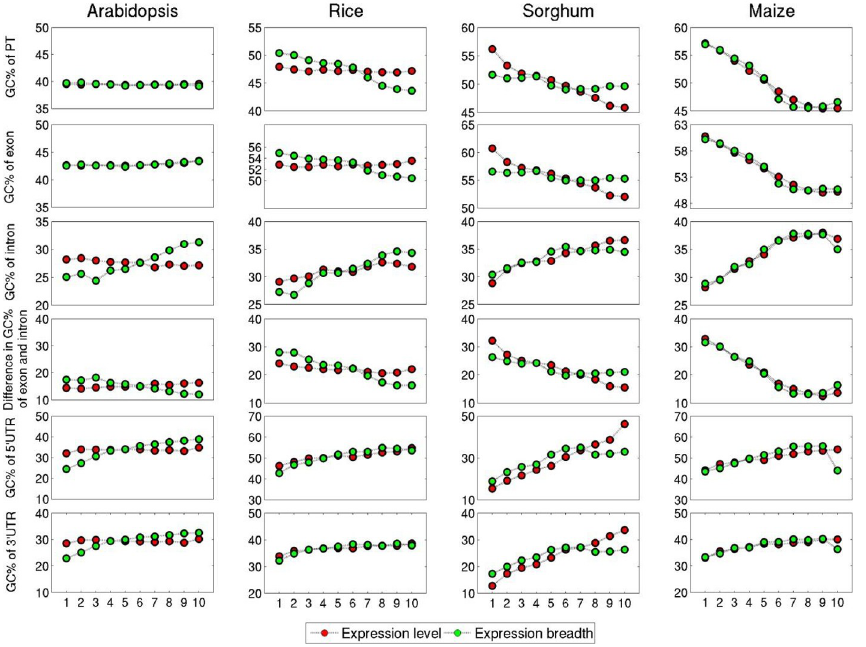
Fig 2. The relationship between 6 different G+C content parameters of plant genes and their expression values. Each panel shows a bin number on x-axis versus the average parameter values with increase in expression level and breadth on y-axis. The dataset is divided into 10 equal bins with 10% of data in each bin. Red and green color dots represent expression level and expression breadth respectively.